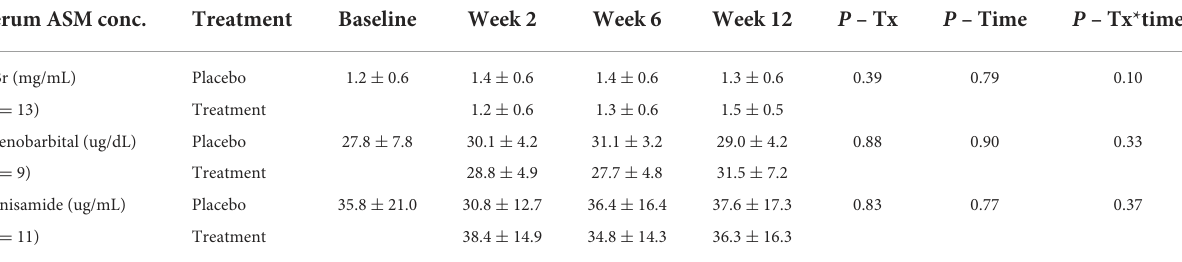
TABLE 3 Serum concentrations of anti-seizure medications [ASM; potassium bromide (KBr), phenobarbital, zonisamide] that were co- administered with CBD/CBDA-rich hemp oil vs. placebo treatment measured at baseline, 2, 6, and 12 weeks. Serum ASM conc.